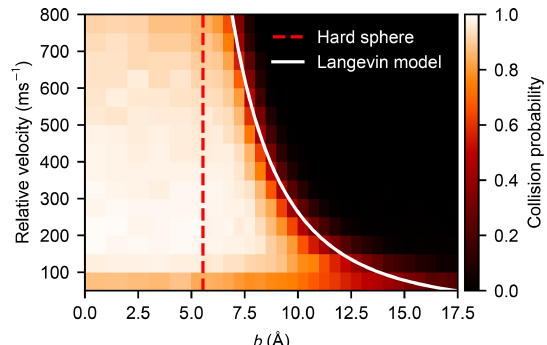
Figure 5. Heat map of the collision probability of sulfuric acid molecules plotted as a function of impact parameter b and relative velocity v obtained from molecular dynamics simulation. The im- pact parameter equivalent to the hard-sphere collision area ( b = 2 R ) and the critical impact parameter obtained from the Langevin cap- ture model (Eq. 9) are indicated by the dashed red and the solid white lines,